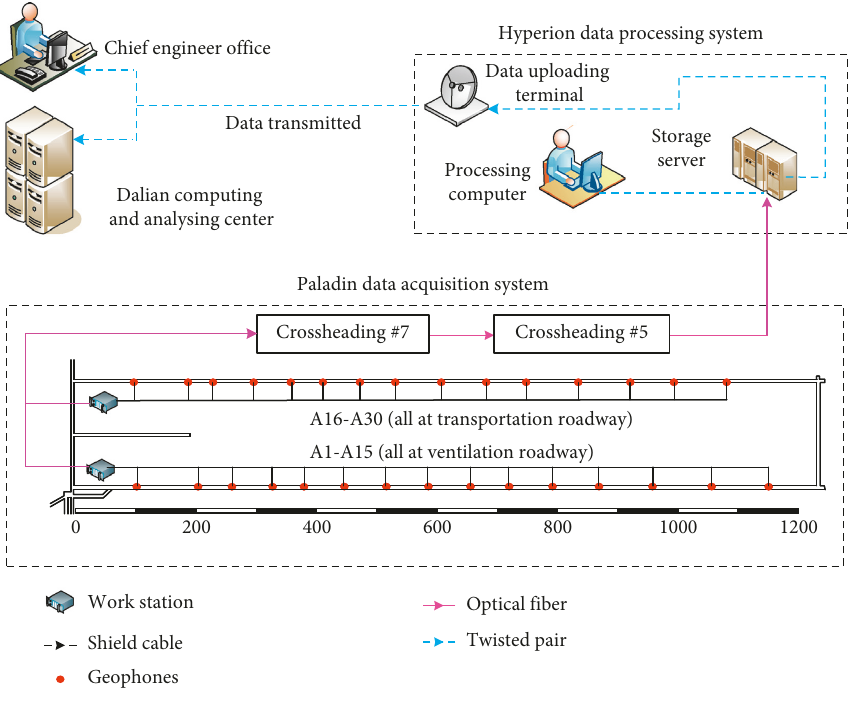
Figure 2: Topology structure of the microseismic monitoring